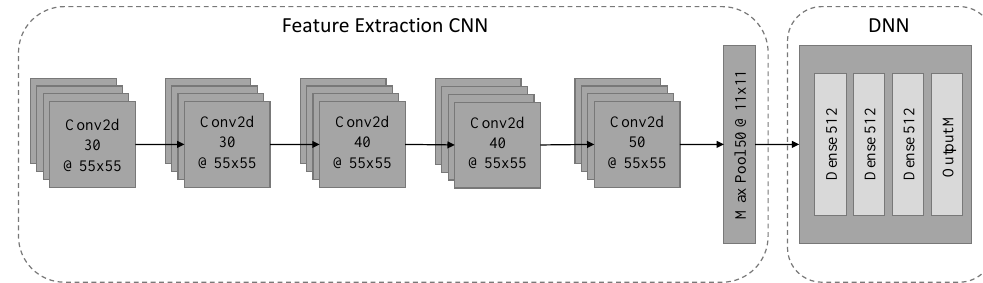
Figure 3. Architecture of the evaluated two-stage NILM model utilizing a two-dimensional CNN for feature extraction and a three layer DNN for regression. For each layer, the number of filter/pooling operations ( X ) and the two-dimensional filter/pooling size ( Y × Z ) is given as ( X @ Y × Z ) . The NILM models were trained using TensorFlow, and the Keras backend was utilised of the architecture is available at https://github.com/pascme05/HF_NILM, accessed on 20 August 2022). The selected values of the hyper-parameters of the models and the parametrization of the Adam optimisation are shown in Table